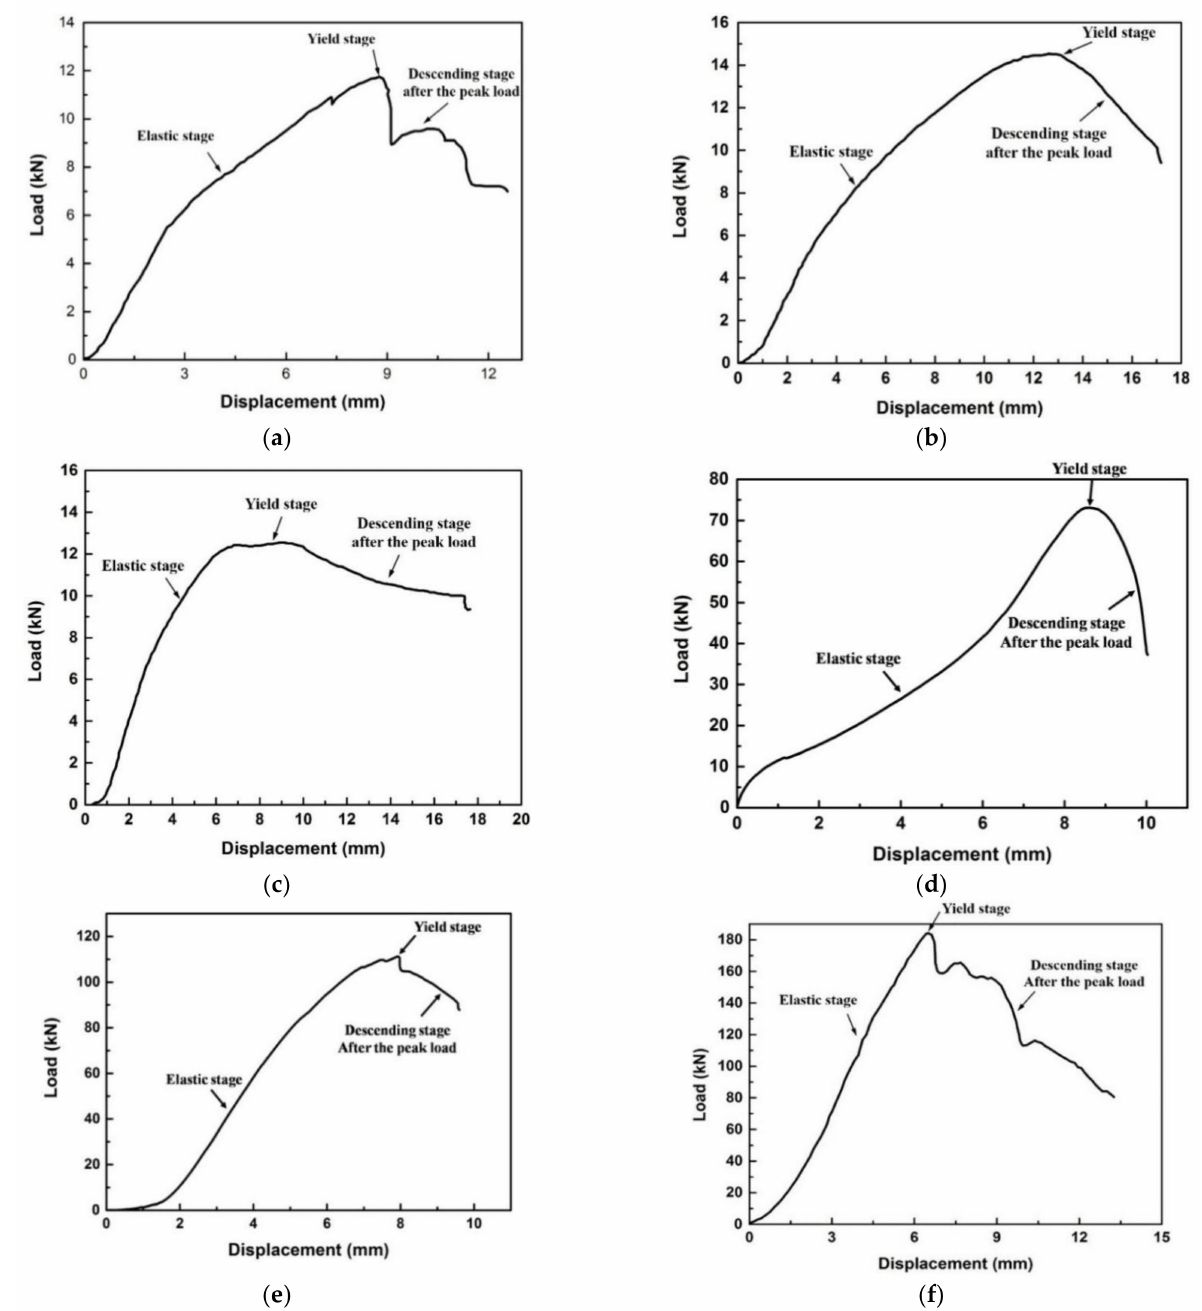
Figure 9. Load–displacement curves of wood-based pyramid sandwich structure and wood-based interlocking grid structure. ( a ) Larch + Birch; ( b ) WPC + Birch; ( c ) OSB + Birch; ( d ) Larch + Larch; ( e ) Plywood + Larch; ( f ) OSB +